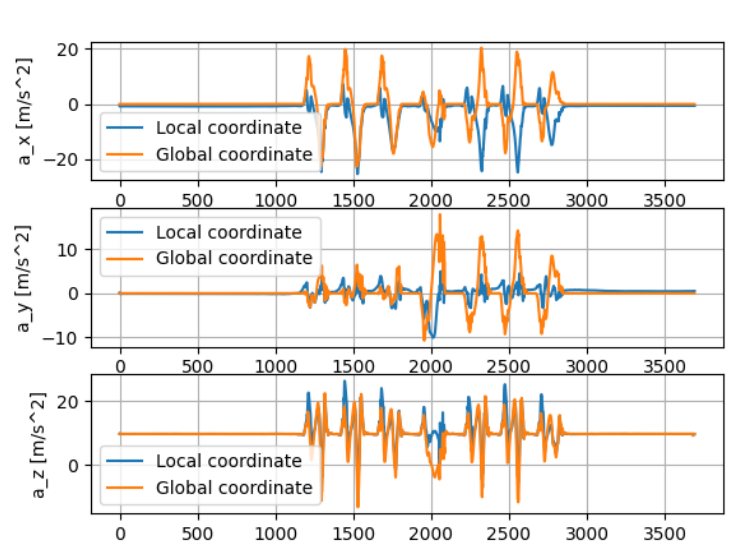
Figure 5. Comparison between local coordinates and global coordinates (The horizontal axes and vertical axes denote the index and acceleration [m/s 2 ], respectively).